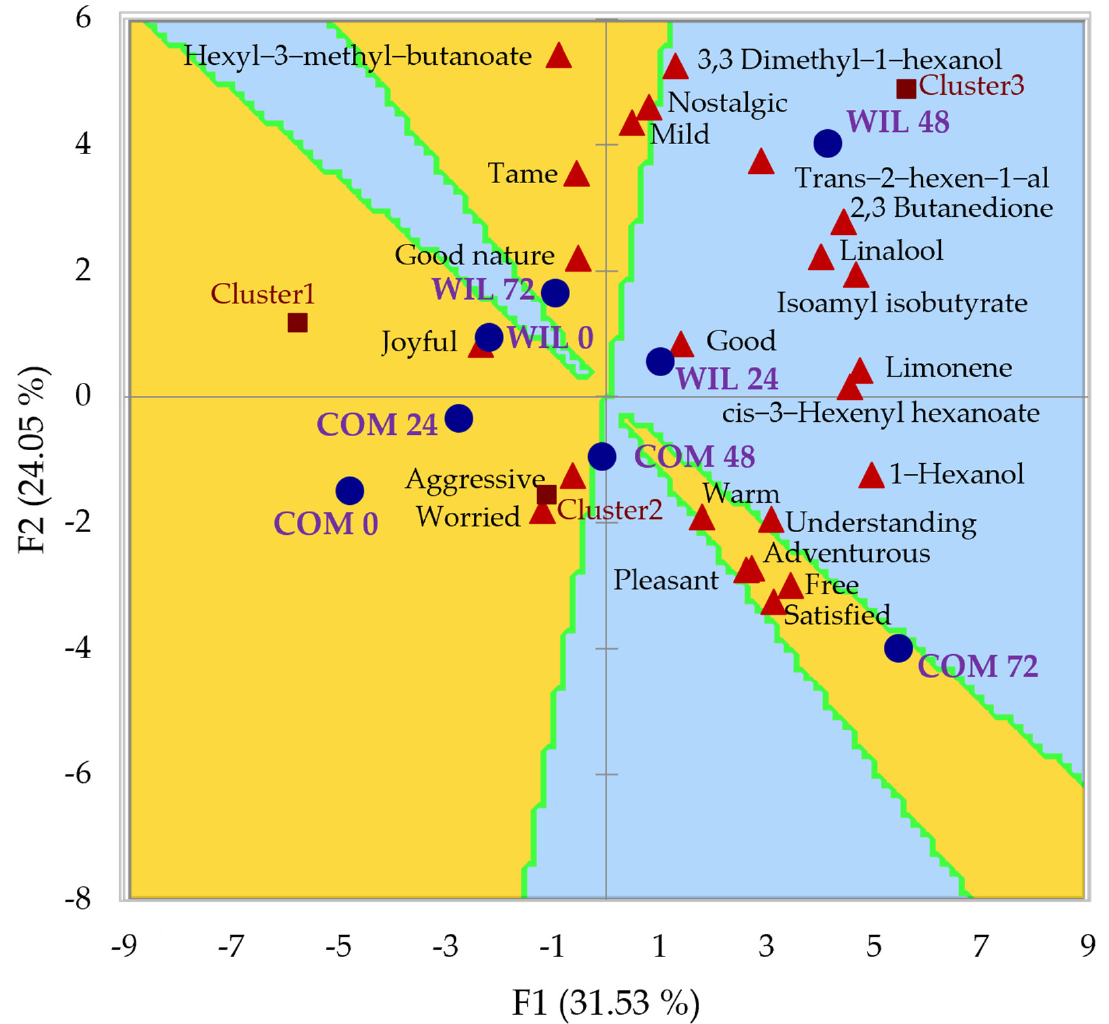
Figure 3. PREFMAP for taste and PCA of volatile compounds and emotions for each strain and time during habanero pepper fermentation. Symbology: ● Fermentation conditions ▲ Volatile compounds and emotions. Preference regions are represented with the following colors: ■ 80 − 100% preference ■ 60 − 80% preference ■ 40 − 60% preference ■ 20 − 40% preference ■ 0 − 20% preference. Abbreviations: PREFMAP, preference map; PCA, principal component analysis; COM 0, 0 h commercial L. plantarum ; COM 24, 24 h commercial L. plantarum; COM 48, 48 h commercial L. plantarum ; COM 72, 72 h commercial L. plantarum ; WIL 0, 0 h wild L. plantarum ; WIL 24, 24 h wild L. plantarum ; WIL 48, 48 h wild L. plantarum ; WIL 72, 72 h wild L. plantarum wild strain.